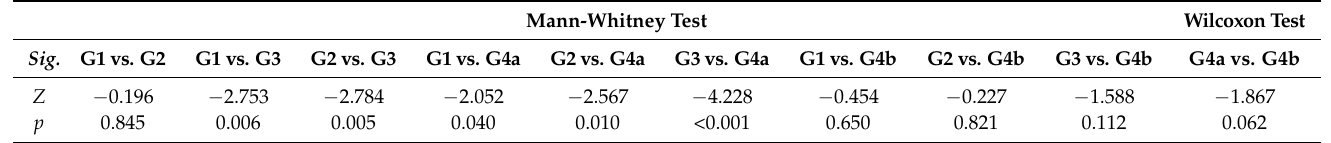
Table 5. Pairwise comparisons of categories